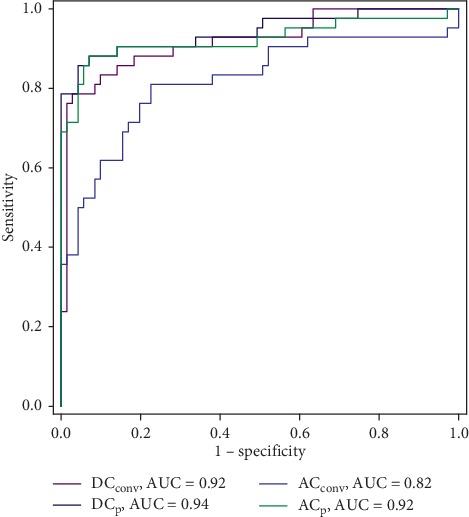
Receiver operating characteristic curves of DC and AC calculated from raw and preprocessed RRI signals.